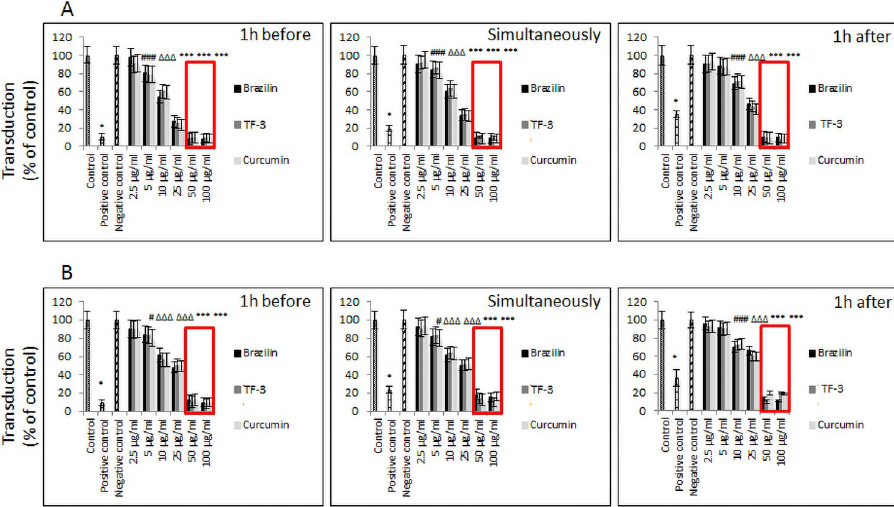
Fig 3. SARS-CoV-2 eGFP-luciferase-pseudo-virion cellular entry. (A) Attachment and entry of SARS-CoV-2 pseudo-virions with encapsulated eGFP-luciferase spike protein was evaluated without spinfection after 48h incubation. (B) Attachment and entry of SARS-CoV-2 pseudo-virions with encapsulated eGFP-luciferase spike protein was evaluated with spinfection after 48h incubation. Data are presented as % of control ± SD; TF-3 –theaflavin-3,3’- digallate # p � 0.05, Δ p � 0.01, � p � 0.001. Control– 0.025% DMSO, positive control—bald SARS-CoV-2 eGFP- luciferase-pseudo-virions, negative control— Δ G-luciferase rVSV pseudo-typed particles; red fame—concentrations that showed 85–100%